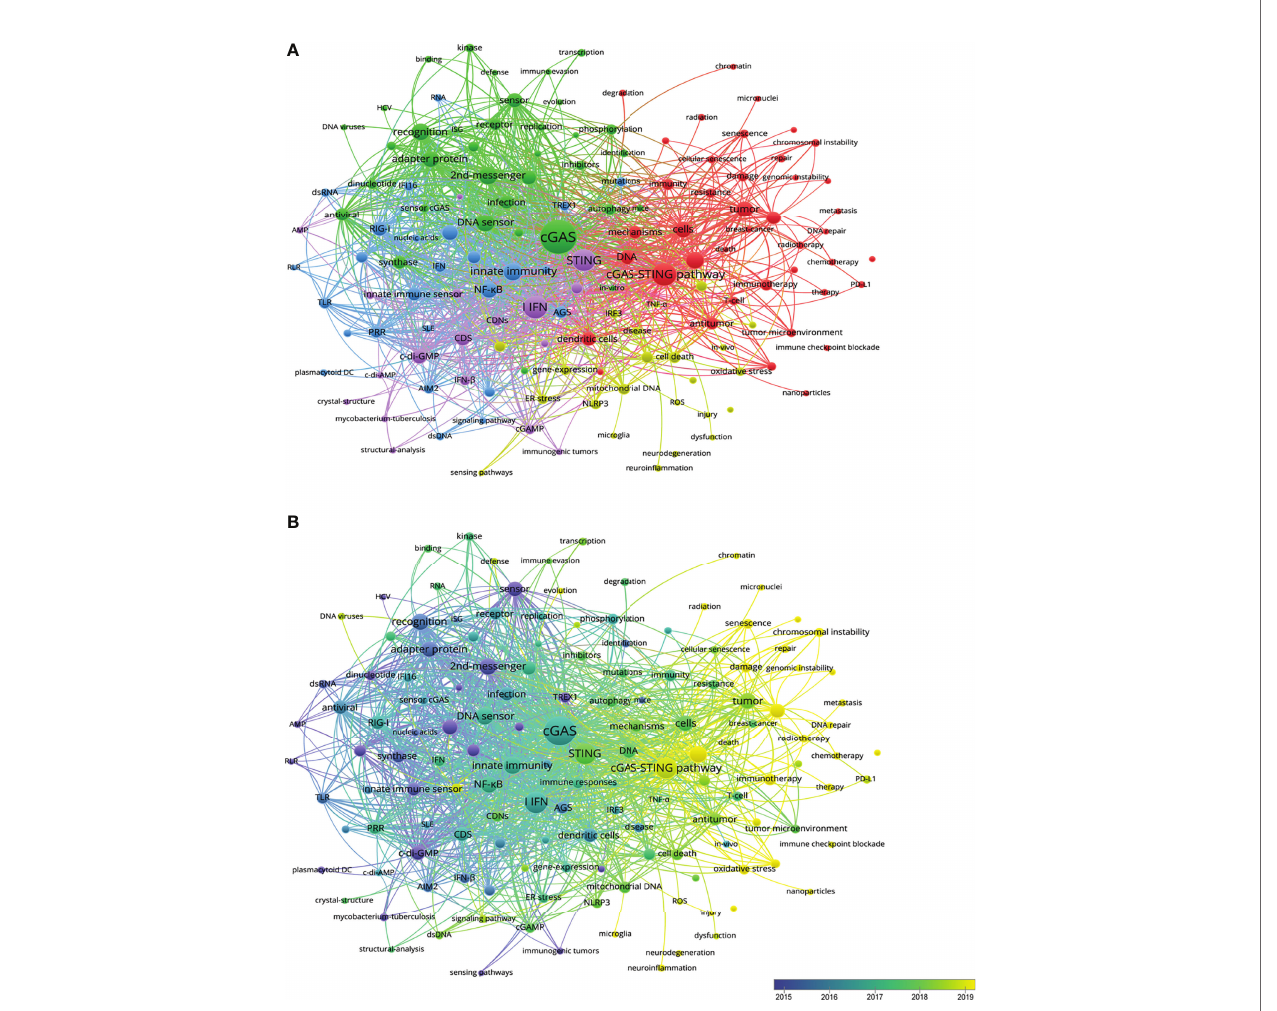
FIGURE 5 | (A) CiteSpace visualization map of keywords clustering analysis related to the cGAS-STING pathway. The size of each nodes represents the frequency of occurrences. (B) Visualization of keywords according to the average publication year. Keywords in yellow appeared later than that in